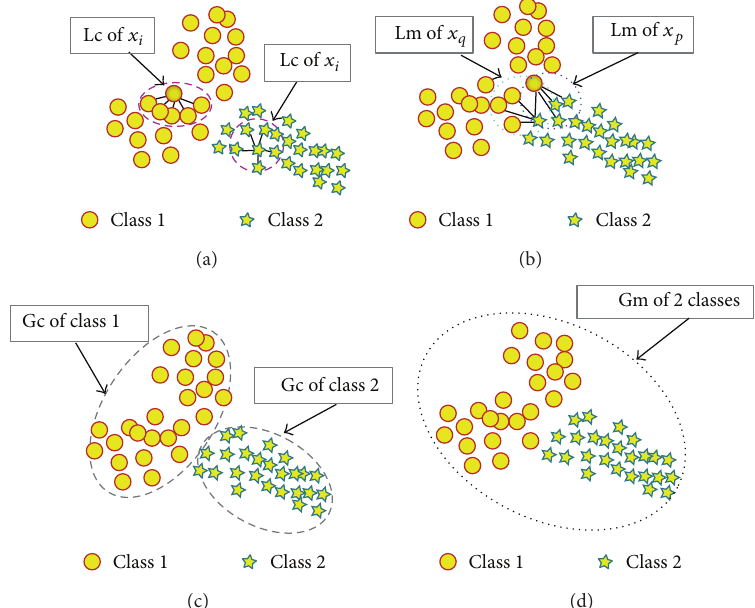
Figure 1: Illustration of local and global constructions for intraclass and interclass, where Lc refers to local compactness, Gc to global compactness, Lm to local margin, and Gm to global